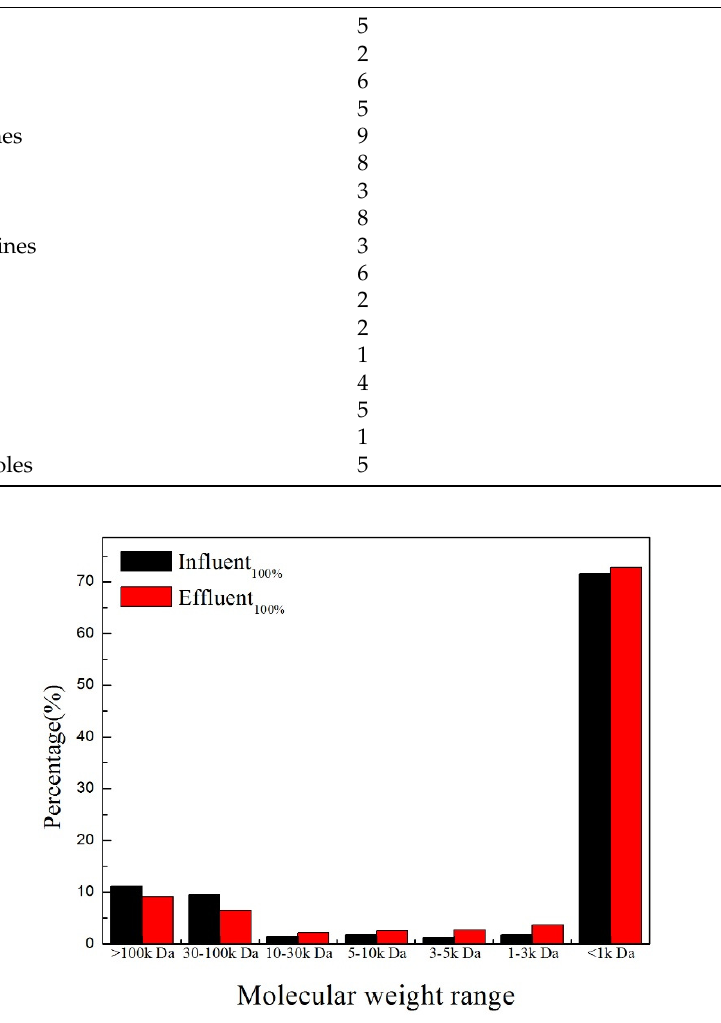
Figure 3. The molecular weight distributions of organic matter during acclimation.